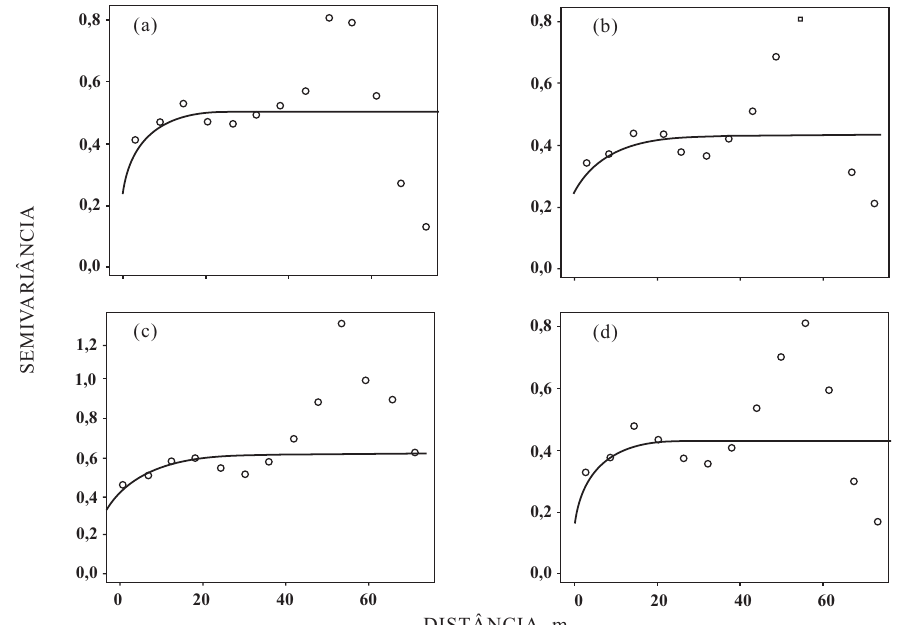
Figura 1. Semivariogramas para armazenagem média no tempo do ano 1 (a), ano 2 (b) ano 3 (c) e média dos três anos (d), para o armazenamento de água no